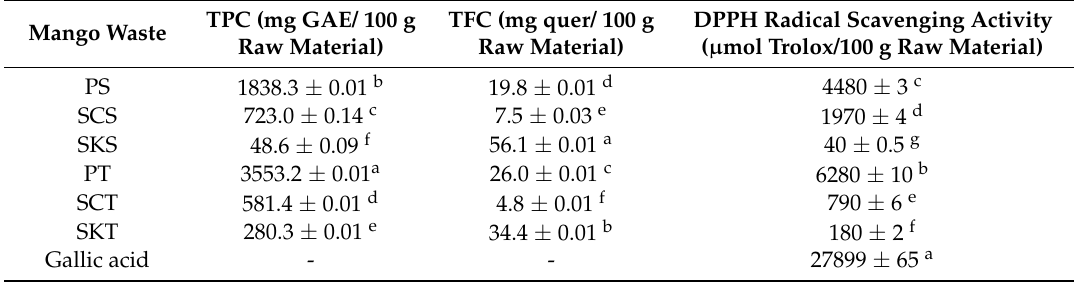
Table 1. Total phenolic content, total flavonoid content, and DPPH radical scavenging of the extracts obtained from mango agroindustrial